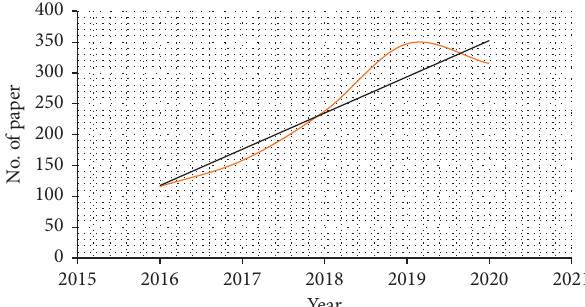
Figure 8: Number of publications in the given years.